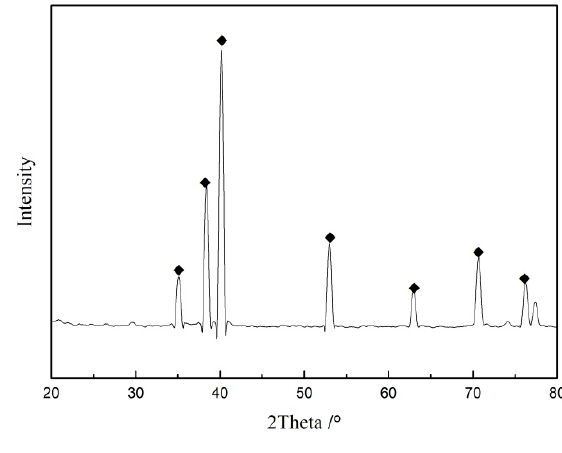
Figure 3. XRD of the porous Ti support.